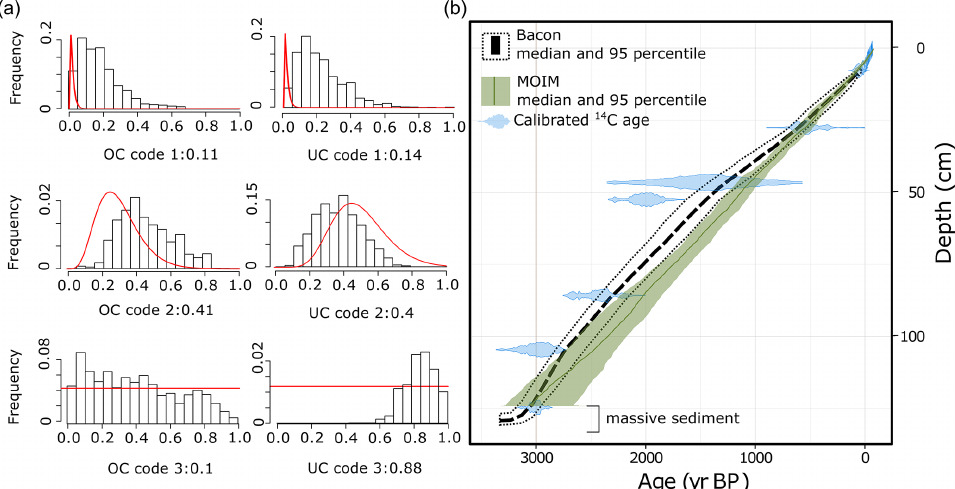
Figure 8. Integrated varve–radiometric model. (a) Over- and under-counting posterior distributions for the multiple observer integrated model (MOIM) for each lamination quality code (1, 2, 3). (b) Age–depth model comparison of the independent (Bacon) age model and the multiple observer integrated model. OC: over-counting. UC: under-counting. The red line indicates the prior